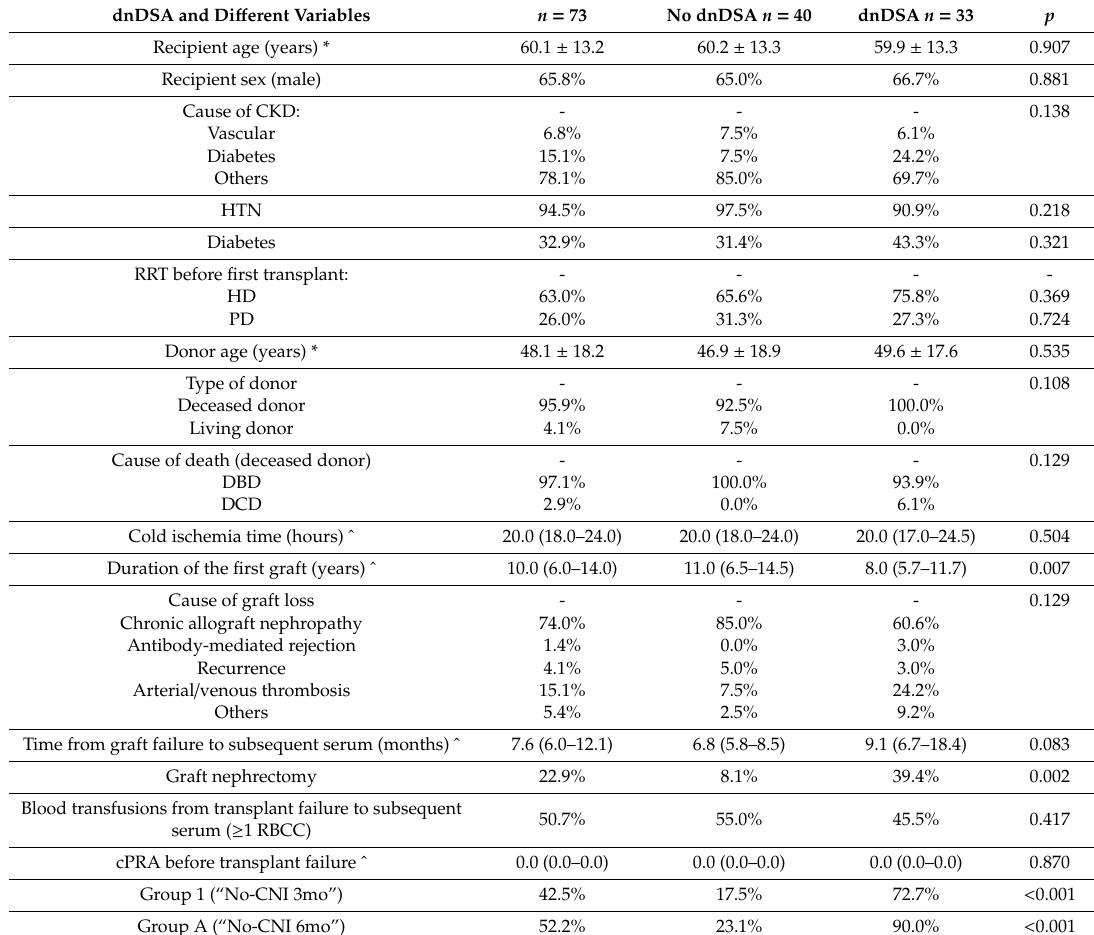
Table 7. Patient characteristics in relation to the development or not of de novo DSA (dnDSA) after transplant failure. Continuous variables were expressed as mean ± SD (*) or median and interquartile range (ˆ) according to their distribution. The bold: p values less than 0.05 defined statistical significance.